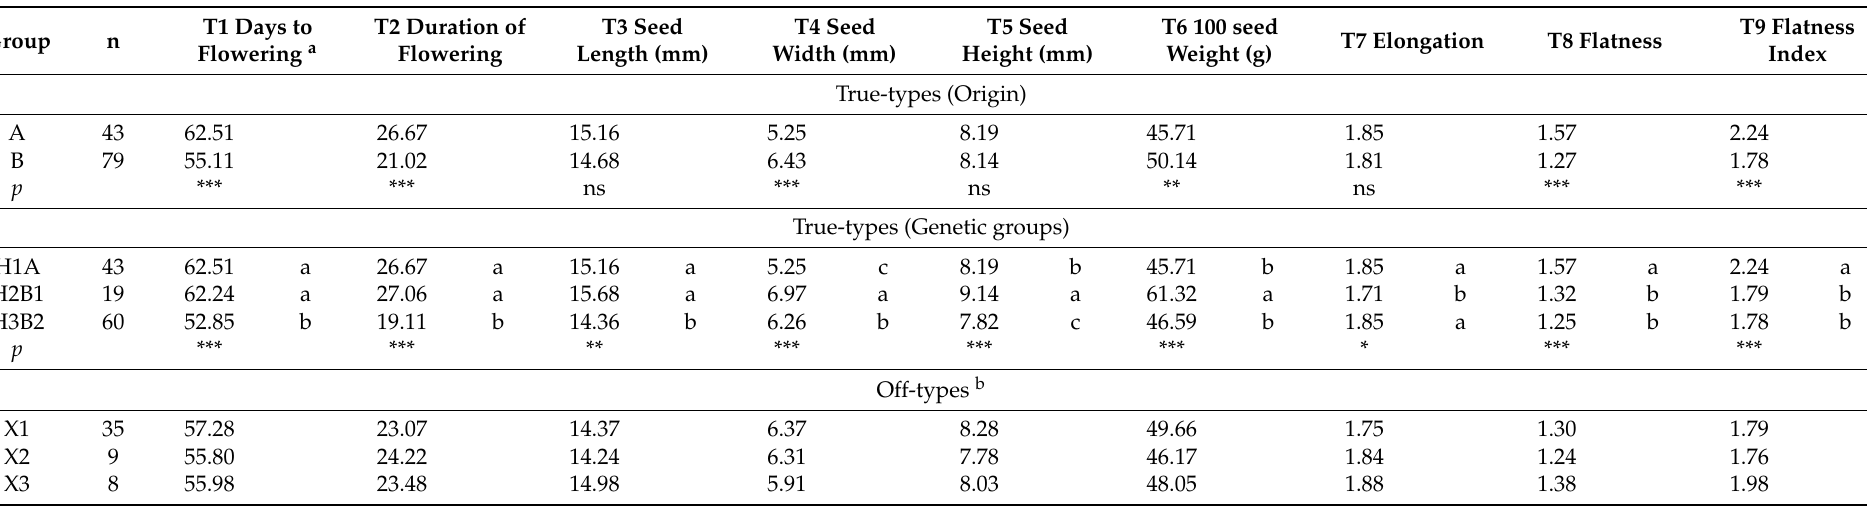
Table 5. Morphological diversity of Croatian common bean accessions. True-type accessions were classified according to (1) centres of origin (A: Mesoamerica, B: Andean) and (2) genetic groups (H1A, H2B1, H3B2).